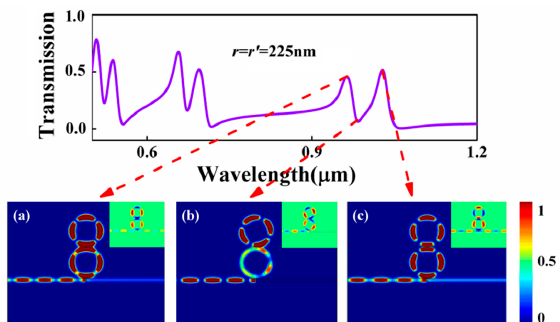
Figure 6. Transmission spectrum of the MIM waveguide with two series-wound ring resonators when r = r ’ = 225 nm; the contour profiles of magnetic intensity distributions | H z | 2 of the device at ( a ) λ = 961 nm; ( b ) λ = 986 nm; ( c ) λ = 1027 nm. The insets denote the corresponding H z distribution of SPPs in the PIT